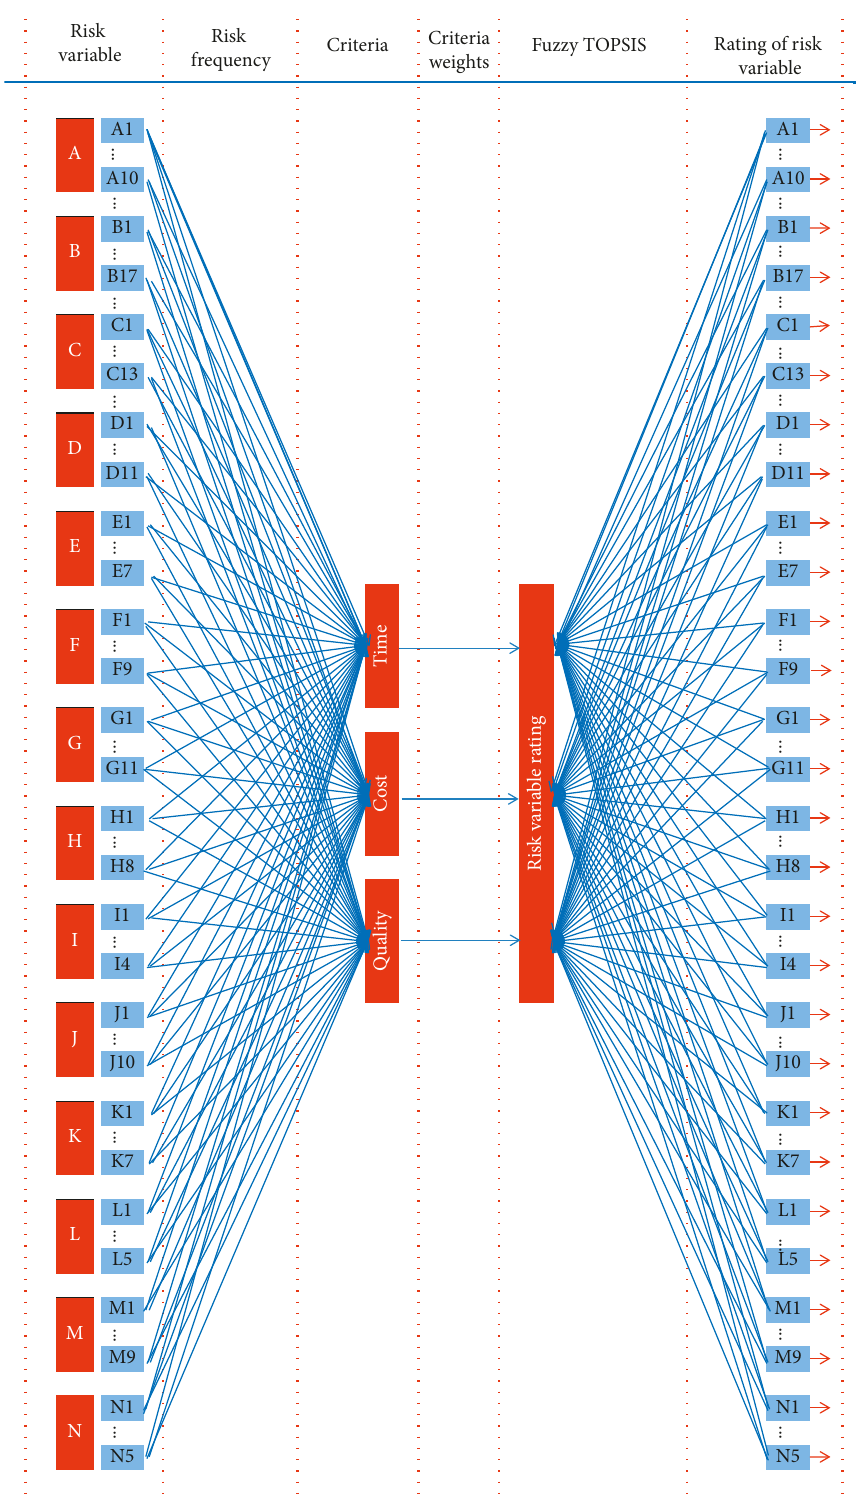
Figure 1: The framework of the research